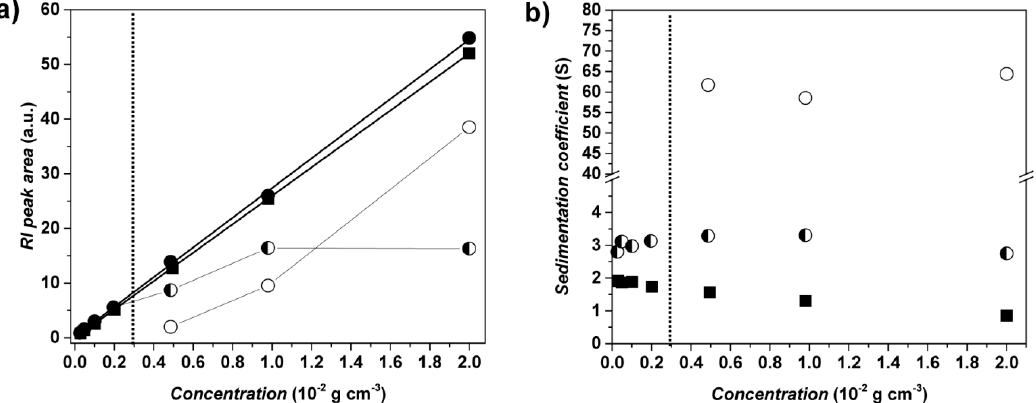
Figure 4. ( a ) Total refractive index (RI) intensities from peak areas of differential sedimentation coefficient distributions, ls-g*(s), for DHBC at varying concentrations (filled squares: without TA; filled circles: with TA) as well as RI peak areas of the population sedimenting at lower sedimentation coefficients (half-filled circles, see Figure 3d) and the abundant larger species (empty circles, see Figure 3d) appearing when non-covalent crosslinking with TA is performed. ( b ) Concentration dependence of the weight-average sedimentation coefficients (filled squares: without TA) and the two populations observed by non-covalent crosslinking with TA, sedimenting with lower sedimentation coefficients (half-filled circles, see Figure 3d) and higher sedimentation coefficients (empty circles, see Figure 3d).